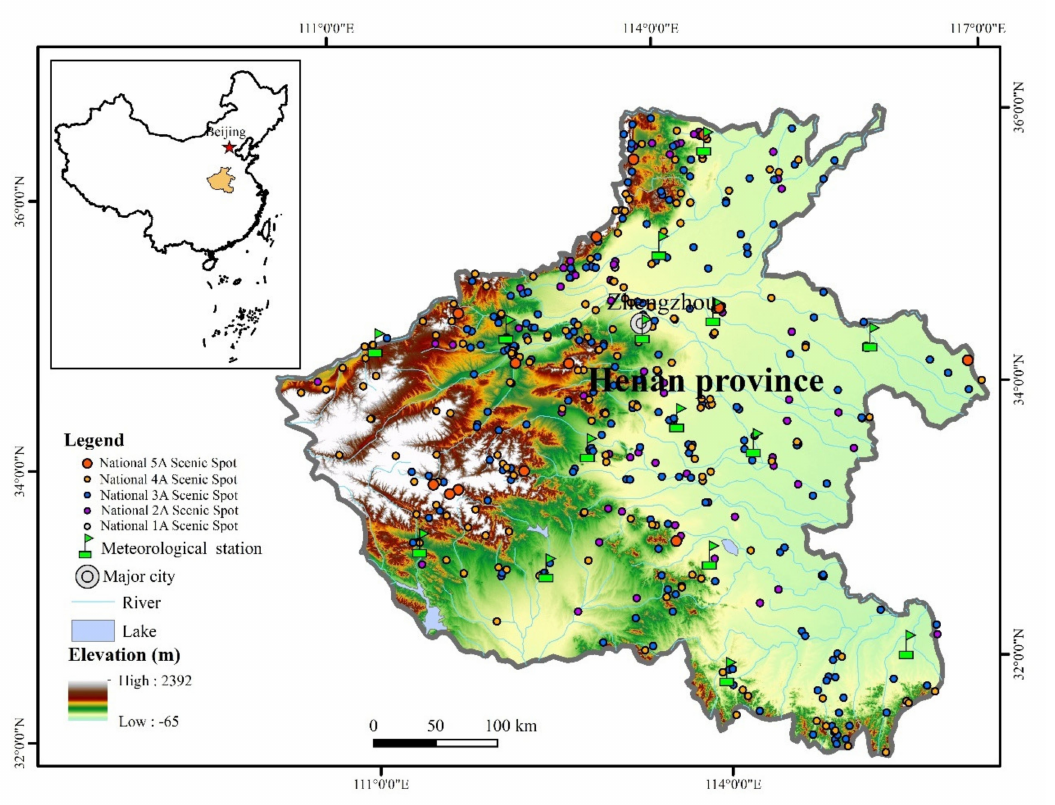
Figure 1. Overview of the study